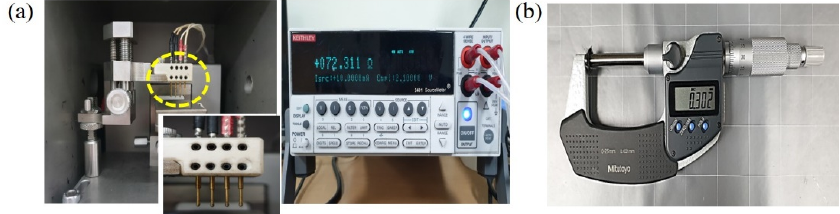
Figure 3. ( a ) Optical images of the four-point probe (left) and source meter (right) used in the experiments; ( b ) optical image of the micrometer used to measure the thickness of the samples.